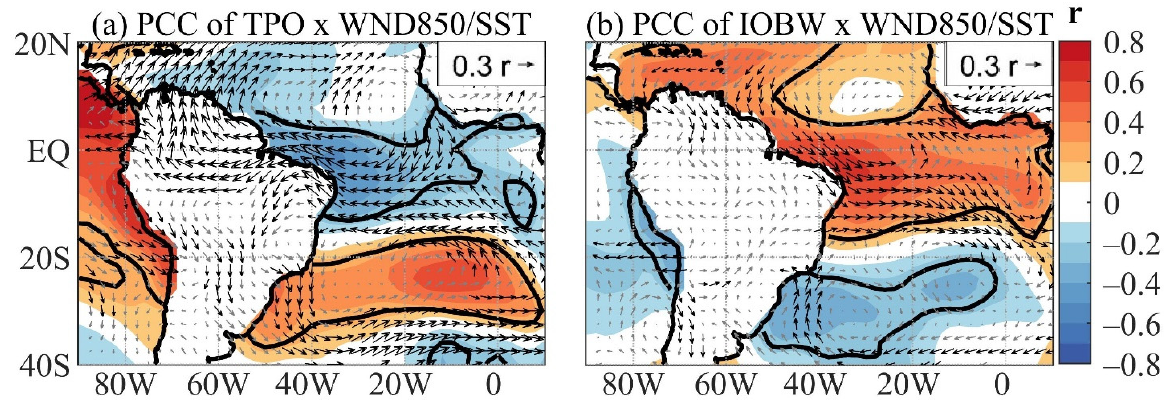
Figure 8. Partial correlations for the SST (shades) and 850 hPa horizontal winds (WND850) during summer of the ( a ) TPO and WND850/SST; ( b ) IOBW and WND850/SST. The continuous line encompasses significant correlations at a 95% confidence level using Student’s t -test. The arrow in the right-lower corner gives the vector base magnitude in correlation units. Bold arrows indicate vectors when at least one component has a significant correlation at a 95% confidence level.